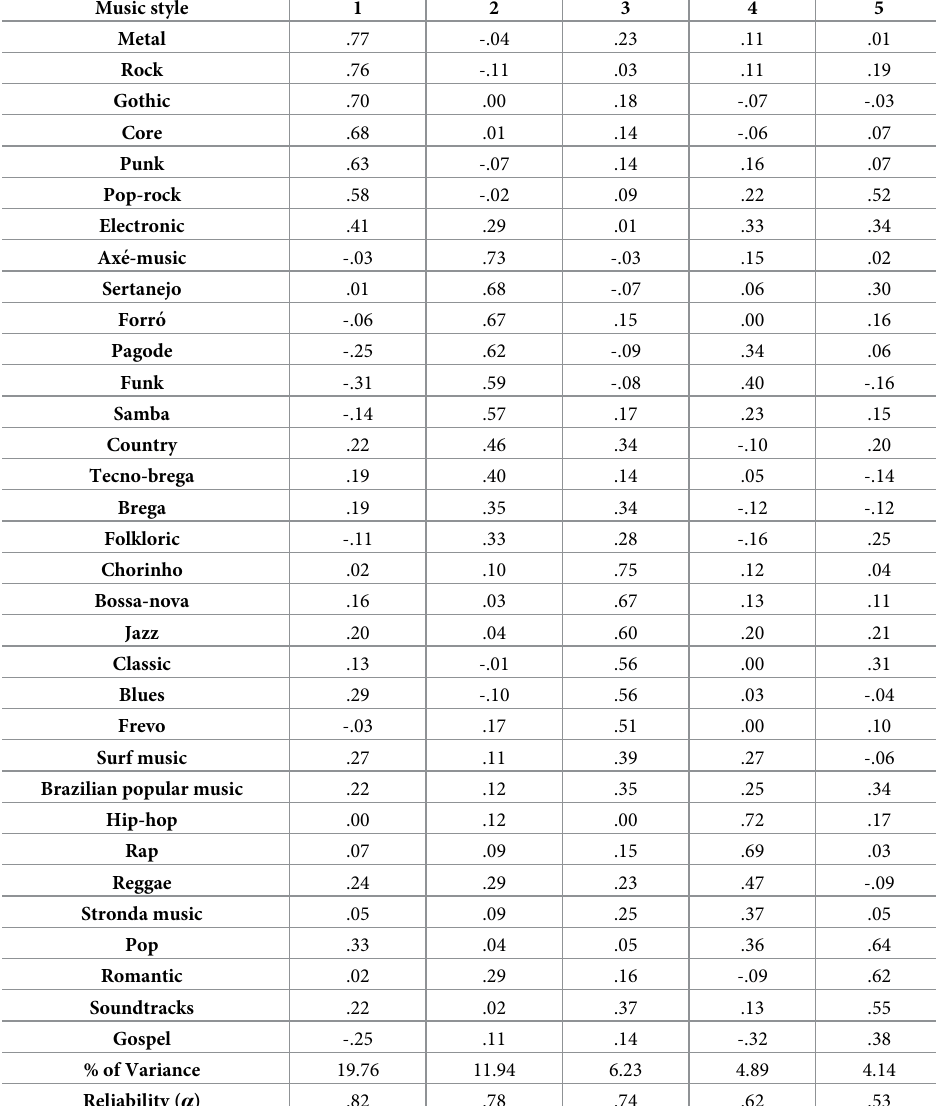
Table 1. Factor loadings based on a principal components analysis with Varimax rotation for 33 music styles in a frequency of listening